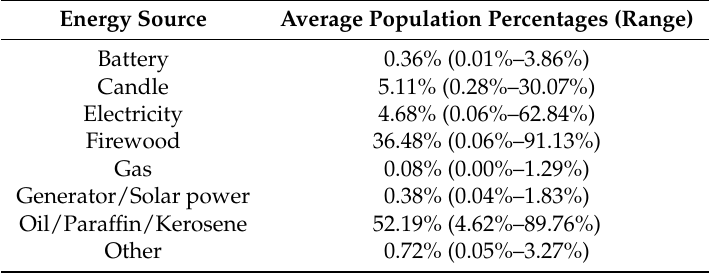
Table 1. Population percentages for each energy source, averaged over the districts. The minimum and maximum population percentage is added between